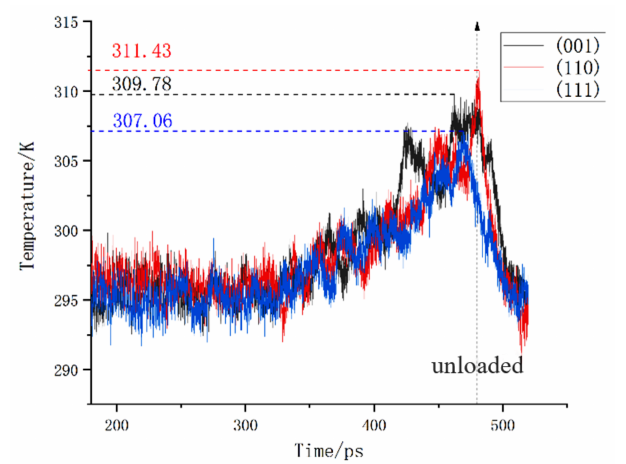
Figure 30. Temperature changes of different loading